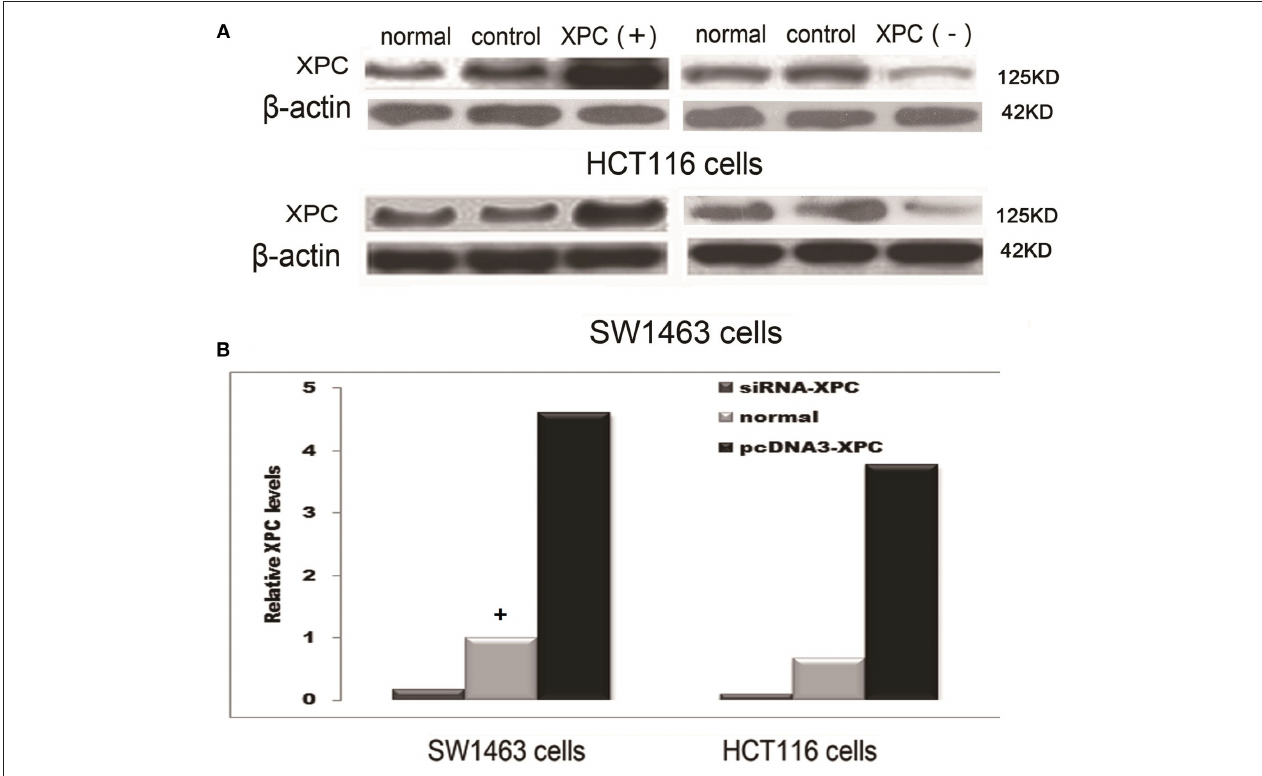
FIGURE 2 | XPC protein expression in SW1463 and HCT116 cells prior to and after transfection with XPC siRNA or pcDNA3-XPC. (A) XPC protein expression by western blot in SW1463 and HCT116 cells. The top image shows a blot that was probed with XPC antibody, while the bottom image shows a blot that was probed with β -actin antibody. (B) XPC relative expression in SW1463 and HCT116 cells. XPC expression in the XPC silenced cells was significantly lower than that in the normal SW1463 and HCT116 cells ( P < 0.01), whereas XPC expression in the pcDNA3-XPC-transfected cells was significantly higher than that in the normal SW1463 and HCT116 cells (Define the column with a “ + ” as baseline, the control group transferred empty plasmid into the cells) ( P < 0.01).